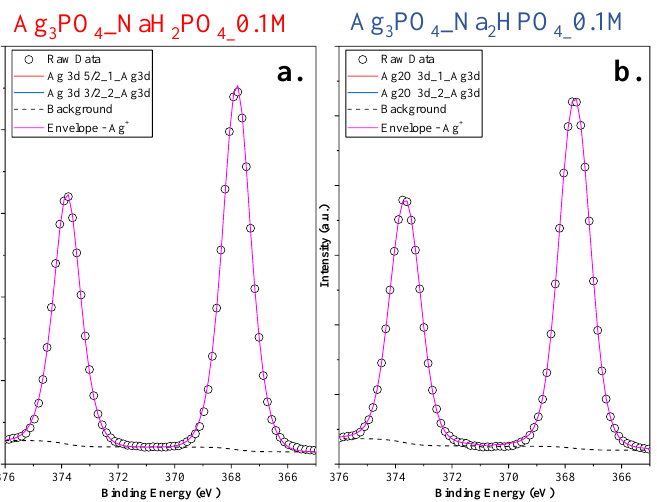
Figure 5. Ag3d XPS spectra of the Ag 3d ( a ) Ag 3 PO 4 _NaH 2 PO 4 _0.1M and ( b ) Ag 3 PO 4 _Na 2 HPO 4 _0.1M samples.